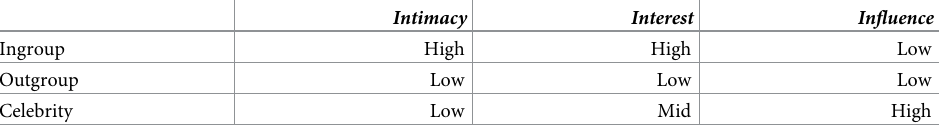
Table 2. Three main components differentiate the target groups. Ingroup members (i.e., close friends) are expected to be high in intimacy and interest, but relatively low in influence; outgroup members (i.e., strangers) low in all catego- ries; and celebrities high in influence, midlevel in interest, and low in intimacy. Intimacy Interest Influence Ingroup High High Low Outgroup Low Low Low Celebrity Low Mid